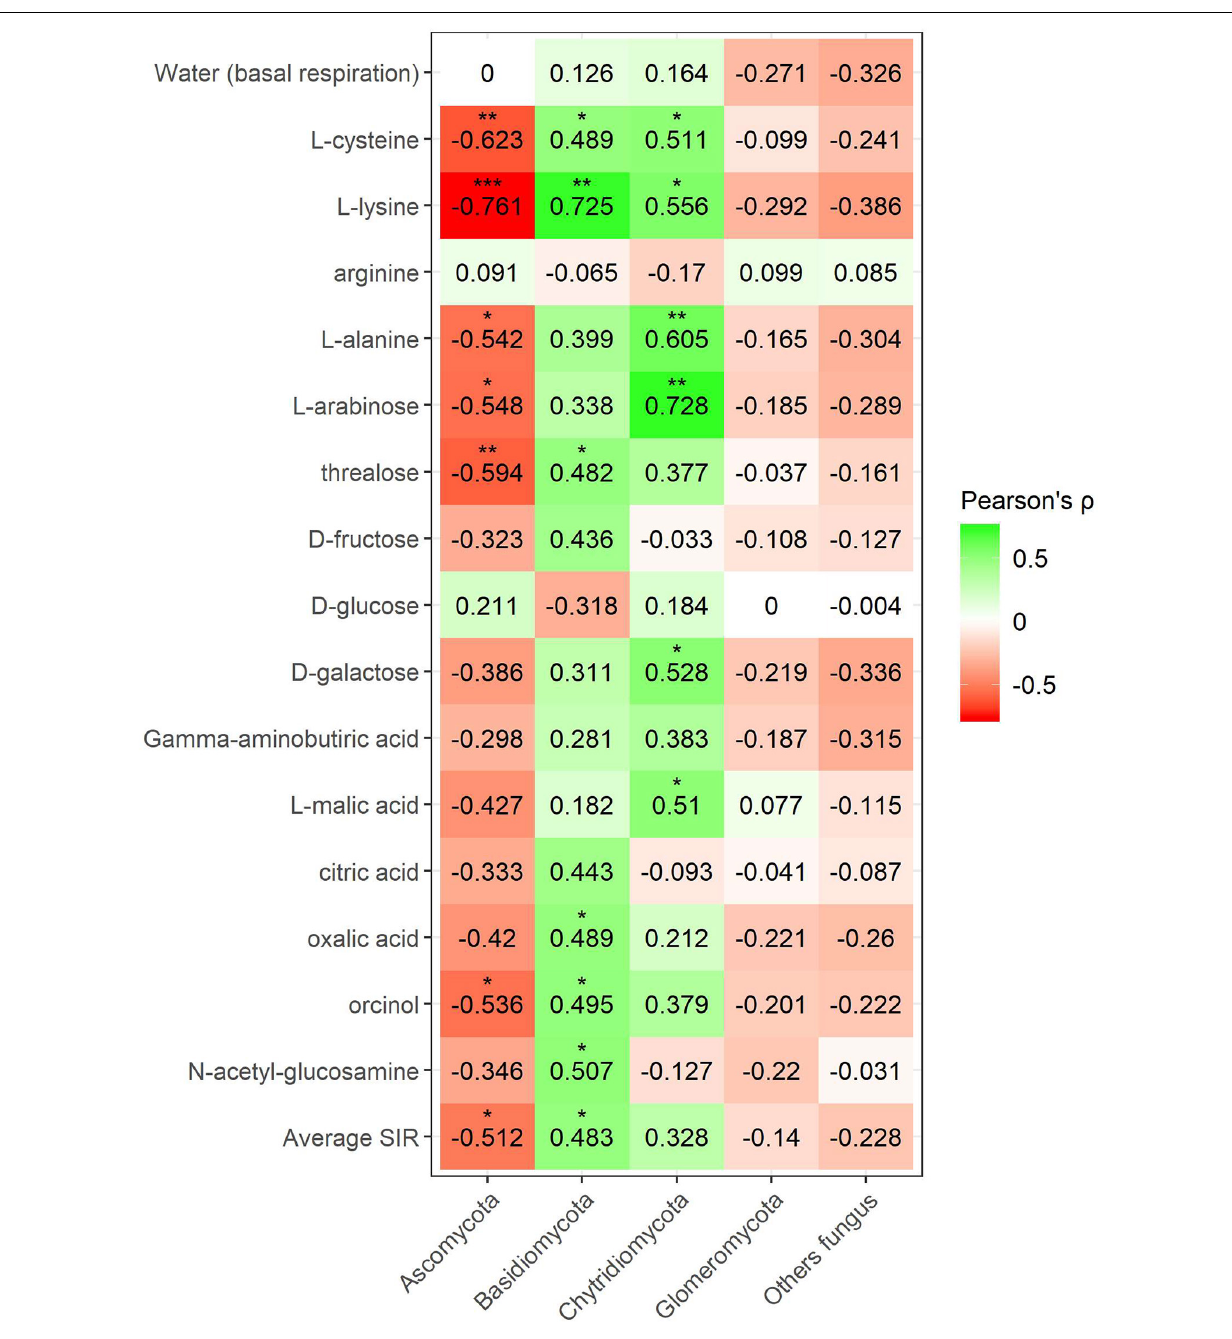
FIGURE 8 | Heatmap of Pearson’s correlation coefficient ( r ) between the most abundant fungal phyla (mineral fertilization–soil effect) and the SIR results of the different carbon sources. Heatmap colors represent the Pearson correlations ranges, from red (negative correlation), passing through white (no correlation) to green (positive correlation). Significant results are indicated by an